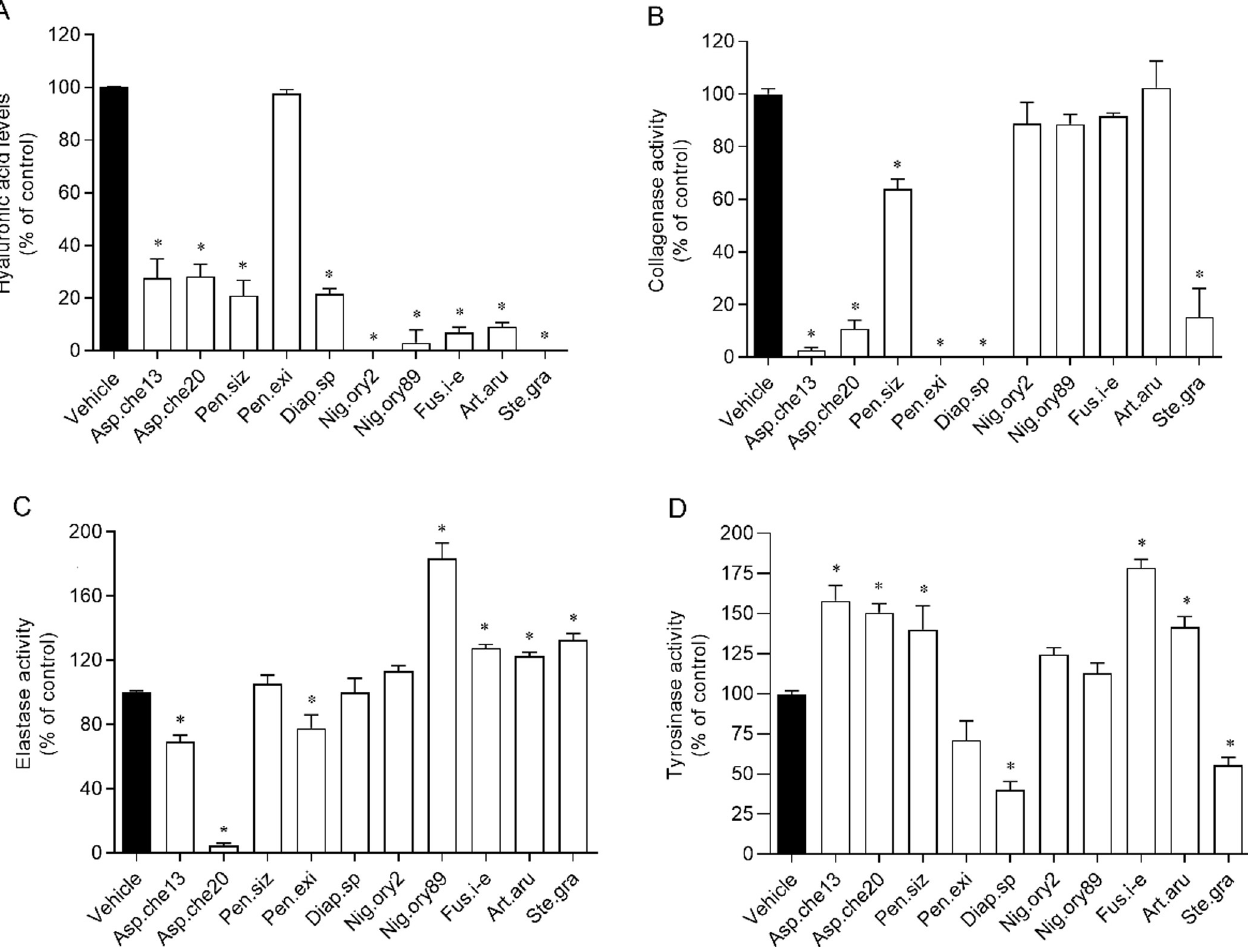
Fig 3. Inhibitory activity of the crude extracts obtained from endophytic fungi associated with Halopteris scoparia against hyaluronidase (A), collagenase (B), elastase (C) and tyrosinase (D) activities: inhibition of hyaluronidase is represented by the percentage of hyaluronic acid that was not degraded in the presence of 200 μ g/mL of each extract; and inhibition of collagenase, elastase, and tyrosinase are represented by the interference of 200 μ g/mL of each extract on their activity. The fungi from which the extracts were obtained are abbreviated as follows: Asp.che13 or 20, isolates 13 or 20 of Aspergillus chevalieri ; Pen.siz, Penicillium sizovae ; Pen.exi, Penicillium sect. Exilicaulis ; Diap.sp, Diaporthe sp.; Nig.ory2 or 89, isolates 2 or 89 of Nigrospora oryzae ; Fus.i-e, Fusarium incarnatum-equiseti complex; Art.aru, Arthrinium arundinis ; Ste.gra, Stemphylium gracilariae . The values correspond to mean ± SEM of 3 independent experiences, in duplicate. � marks significant differences (One-way ANOVA, Dunnett’s test; p < 0.05) when compared with the vehicle.